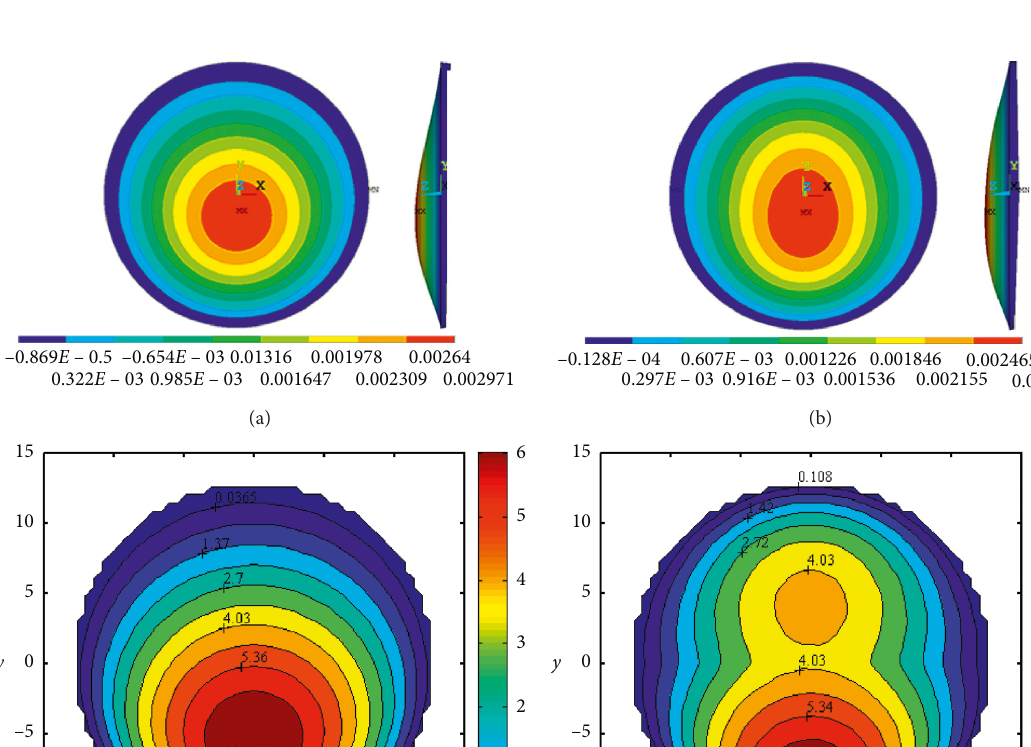
Figure 2: Model of geometry of the membrane. (a) Front view with constraint of full edge clamped. (b) Side view with one direction inclined membrane. (c) Side view with two directions inclined membrane. (d) Freeform surface structure with constraint of full edge clamped.